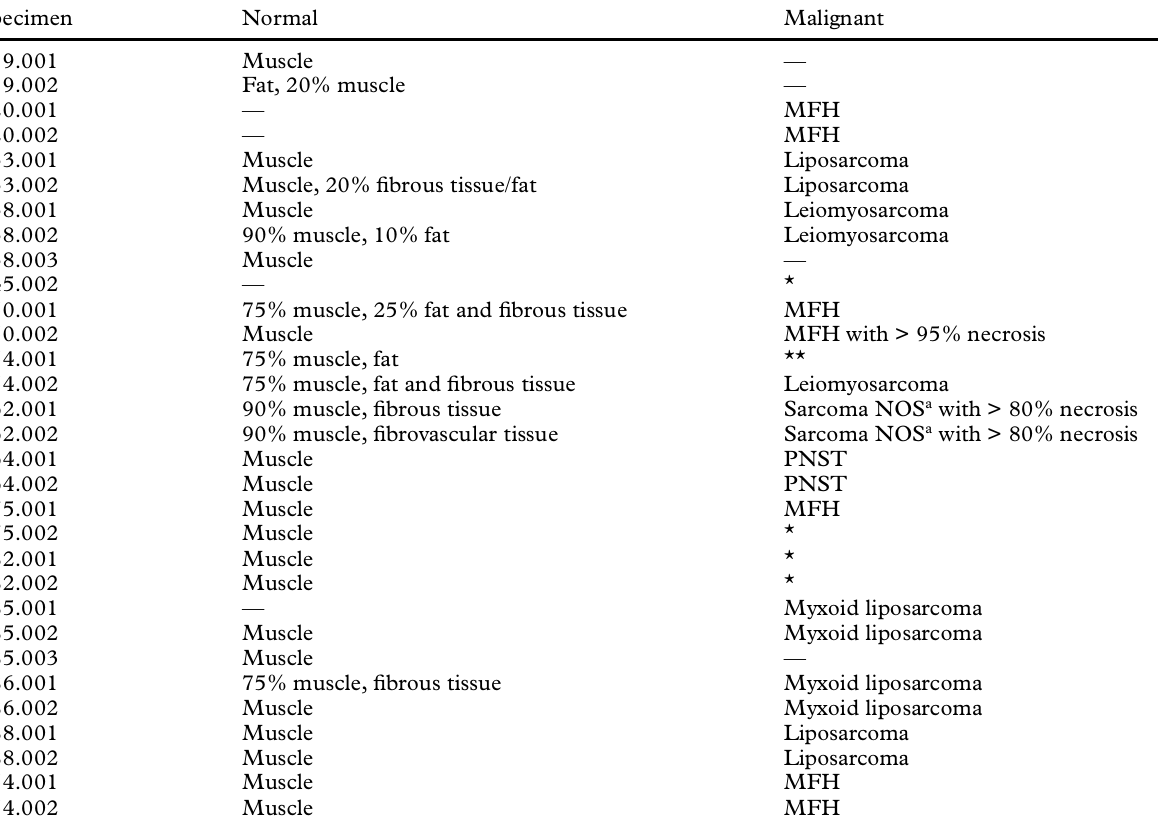
Table 1. Histological data of the soft tissue specimens included in the